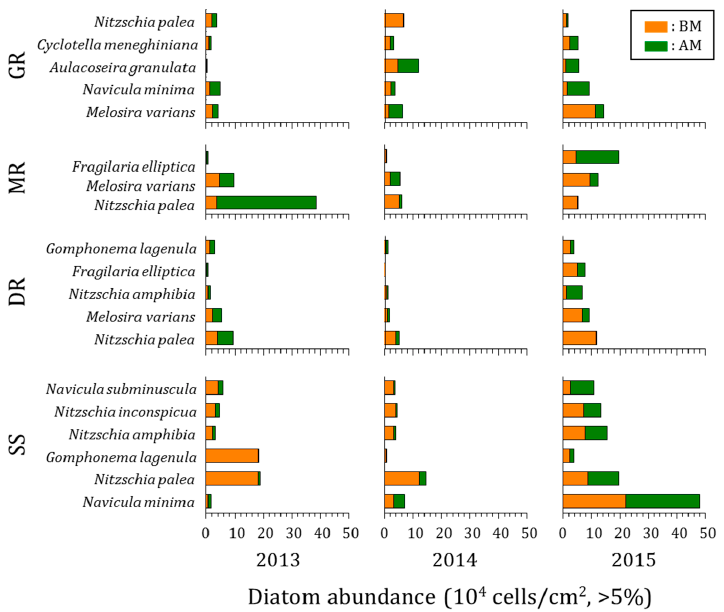
Figure 7. Epilithic diatom abundance of the most abundant species in four central western major streams of the Korean Peninsula before and after monsoons from 2013 to 2015. Top 5% of total abun- dance (GR: Geumgang River, MR: Mangyeonggang River, DR: Dongjingang River, SS: Sapgyocheon stream), BM: before monsoon, AM: after the